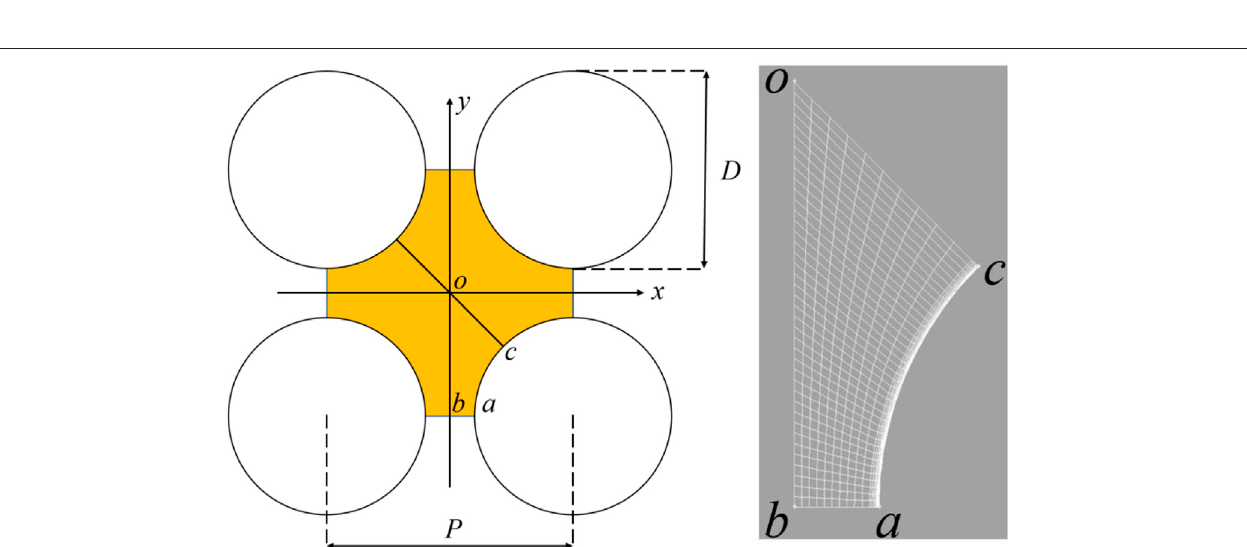
FIGURE 6 | Schematic diagram of the quadrilateral in fi nite rod bundle. (A) fl ow area; (B) local mesh.